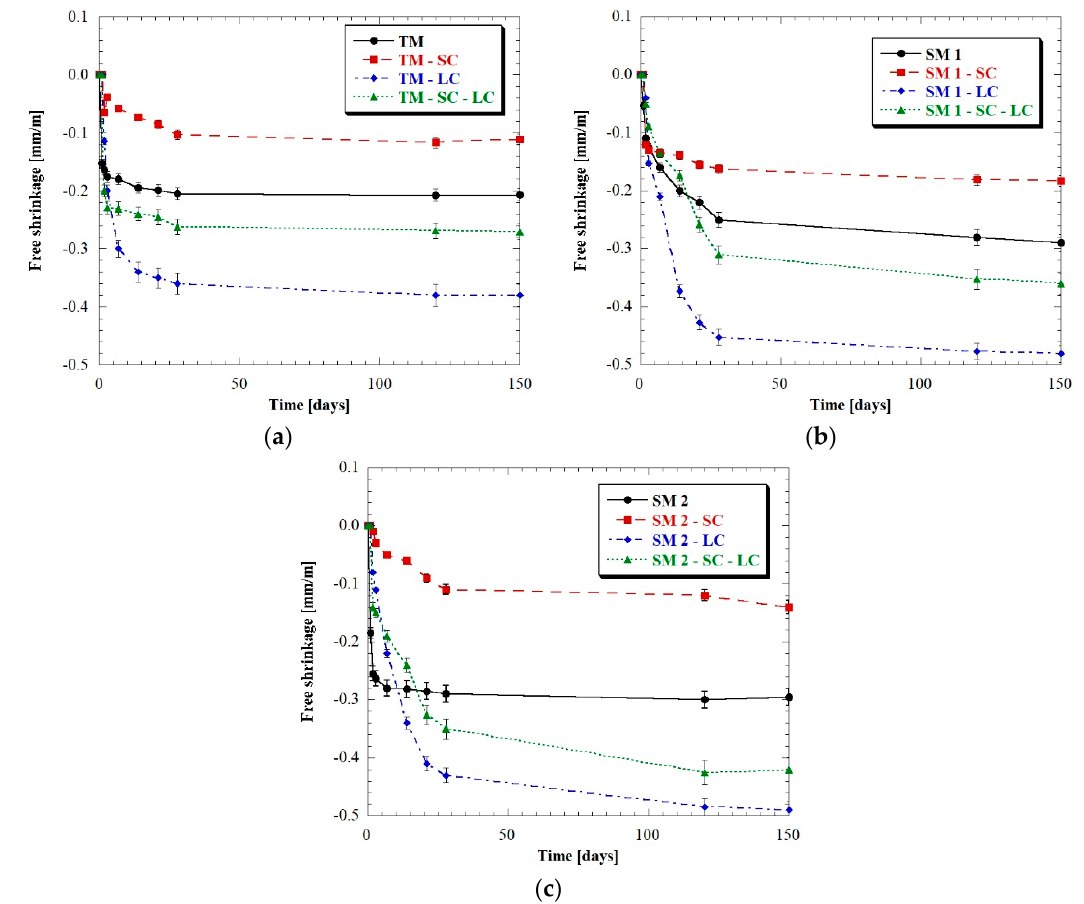
Figure 6. Free shrinkage of mortar ( a ) TM, ( b ) SM1 and ( c ) SM2 with different admixtures.